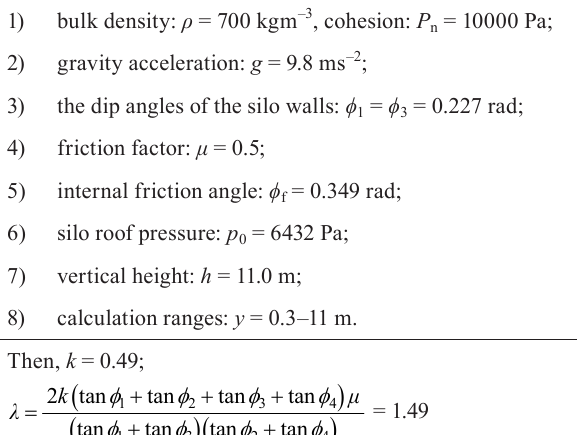
Table 2 Applied parameters of a pyramidal